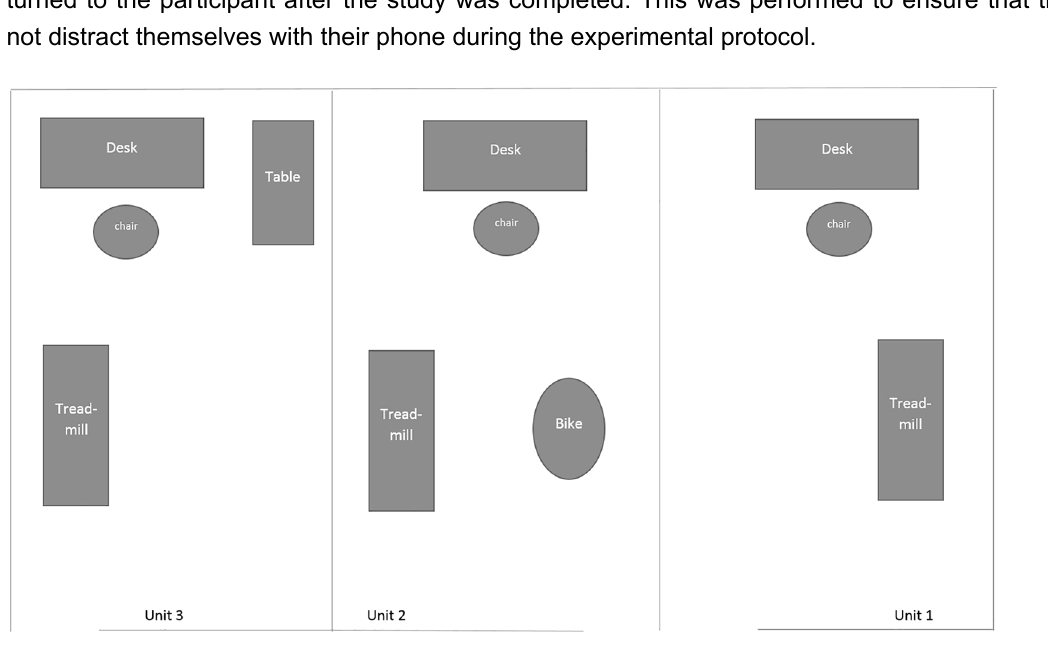
Figure 2. Schematic overview of the laboratory set-up for Experiment